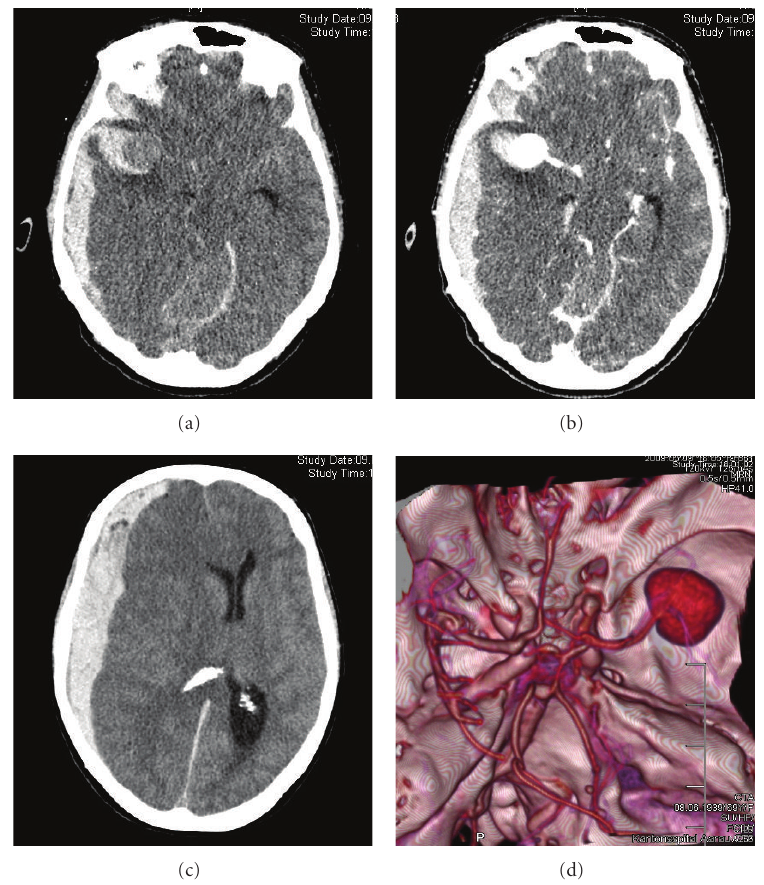
Figure 2: Illustrative case: Panels (a–d) display axial CT scans with 3D reconstructions showing a right acute subdural hematoma with midline shift after rupture of a giant aneurysm located in the right middle cerebral artery. Panels (a) and (b): noncontrast-enhanced and contrast-enhanced axial CT scan, demonstrating a large aneurysm in the right silvian fissure with surrounding SAH, right-sided aSDH, and uncal herniation. Panel (c) shows a marked midline shift due to the mass e ff ect of the aSDH. Panel (d) depicts the aneurysm with outgoing